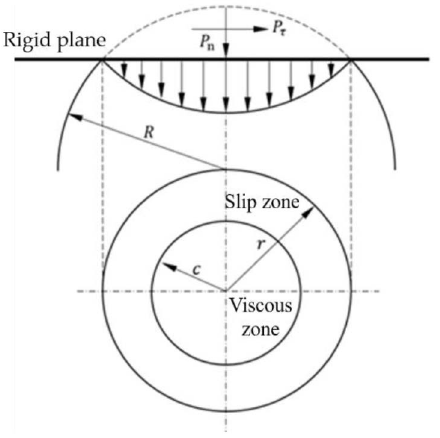
Figure 3. Stick–slip contact model of the microconvex body.